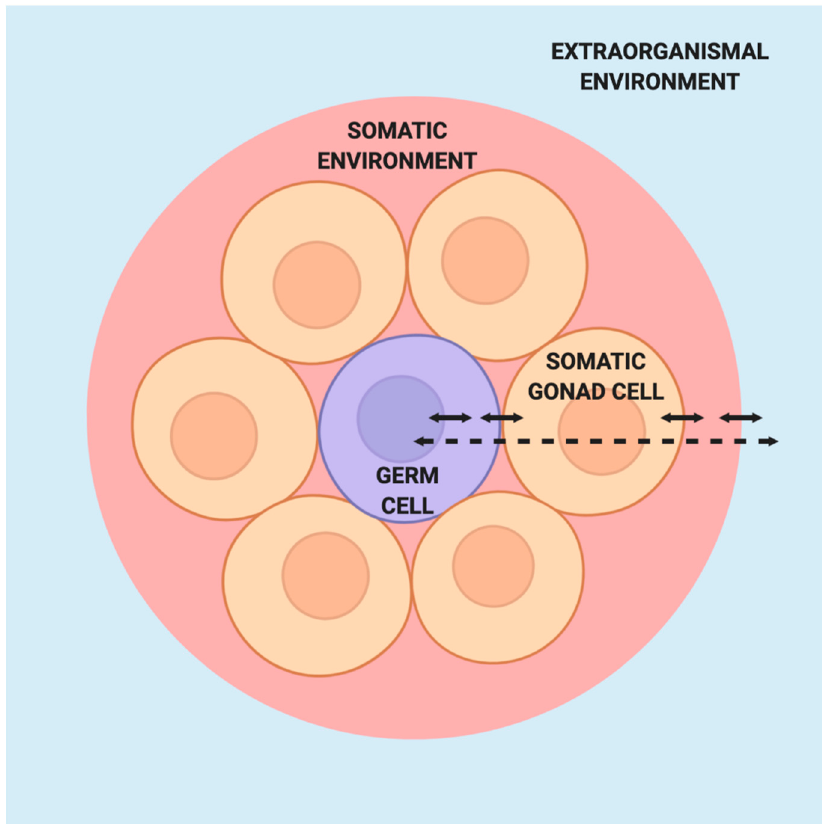
Figure 3. Model of germ cells in the absence of the Weismann barrier. Within the germ cell (purple), interactions between the nuclear and cytoplasmic components integrate signals from the surrounding somatic gonad cells, which themselves are responsive to signals from the germ cell. The germ cells and somatic gonad cells are situated within a larger somatic environment that is in turn influenced by the extraorganismal environment.